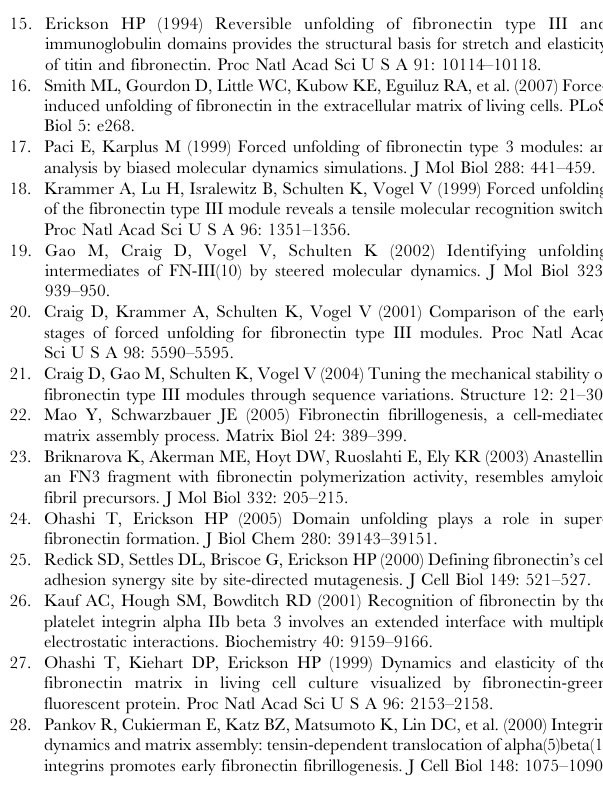
Figure S1 Evaluating the Role of Electrostatic Interactions Involving b -strand A. (A) Snapshots of the N-to-RGD unfolding trajectory with (right) and without (left) strand A electrostatic contributions ignored. Comparison of the unfolding trajectories for the same initial conditions, but calculated for either the normal energy potential (U) or the modified electrostatic energy potential (UE), show minimal differences between the unfolded structures. (B) Solvent accessibility factor of the b -strands. The pattern of solvent accessibility of the secondary structural elements (labeled at left) calculated every 3 ns throughout the trajectory show similarities between the two N-to-RGD unfolding profiles for normal and modified electrostatics. Figure S2 Energy Contributions Significant for 10FNIII Me- chanical Stability Along the N-to-RGD Axis. (A) Electrostatic energy contributions to the force profile. The black curve denotes the N-to-RGD force profile with the full potential energy function. For the same starting structure, the force profile (magenta) is calculated with the electrostatic interactions involving strand A turned off as outlined in the text. (B) Contributions due to bond length, bond angle, and van der Waals energy terms to the force profile. The black curve represents the magnitude of the external pulling force needed to unfold 10FNIII. The blue curve is the